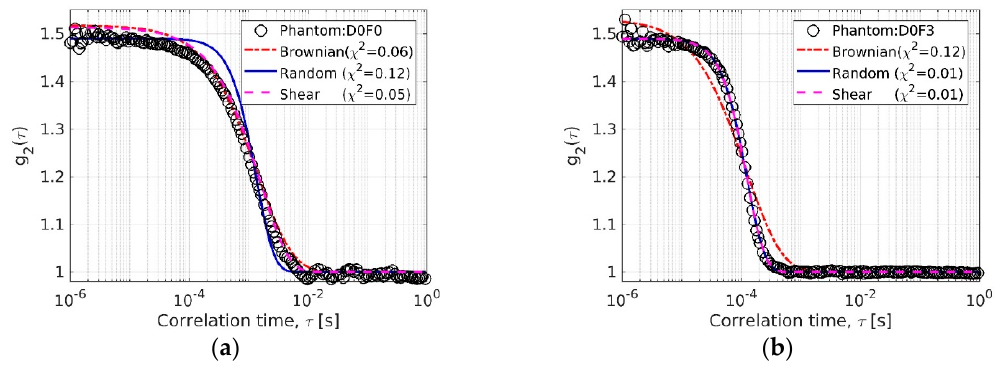
Figure 9. Experimental data (symbols) and fits using Equation (2) for three di ff erent flow models (dash-dotted: Brownian; solid: Random; dashed: shear) for two di ff erent flow phantoms. ( a ) shows representative data in phantom D 0 F 0 (pump flow turned o ff ) while ( b ) shows data from phantom D 0 F 3 (highest pump flow).